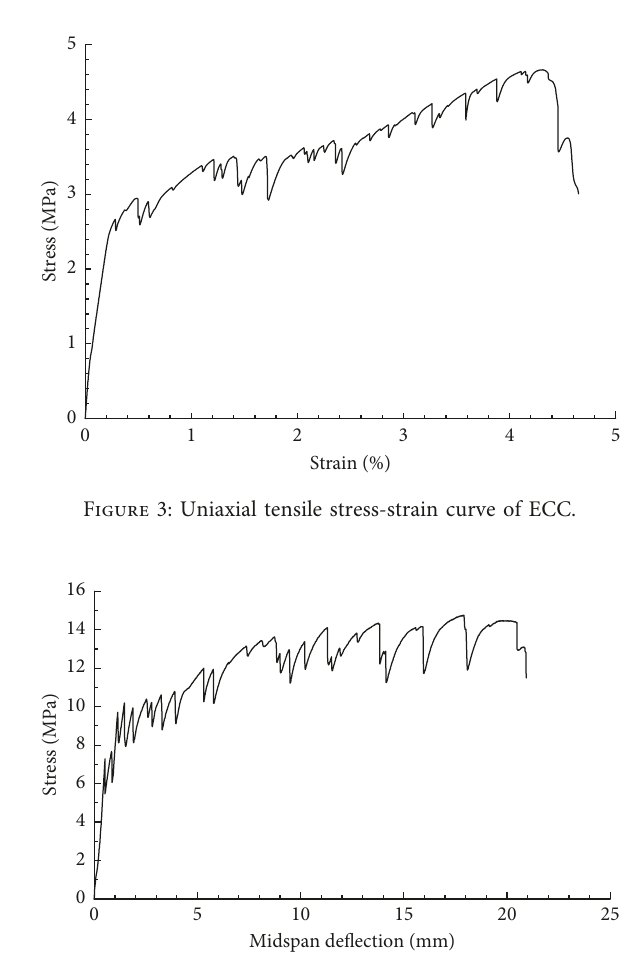
Figure 4: Midspan deflection under flexural